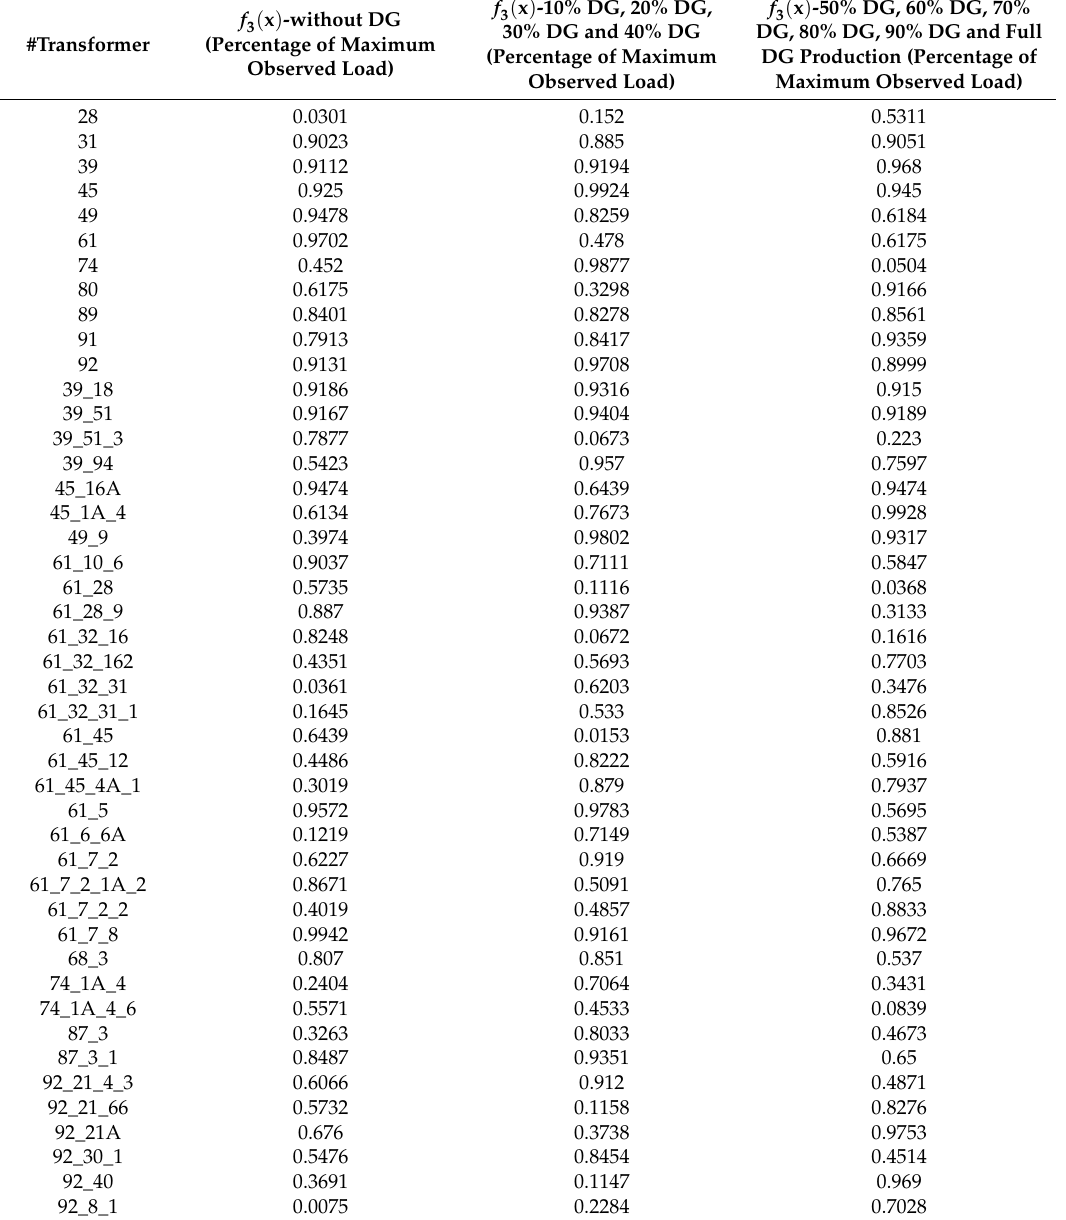
Table 5. Optimal loading per node according to f 3 ( x ) for increasing production up to the distributed generator’s installed